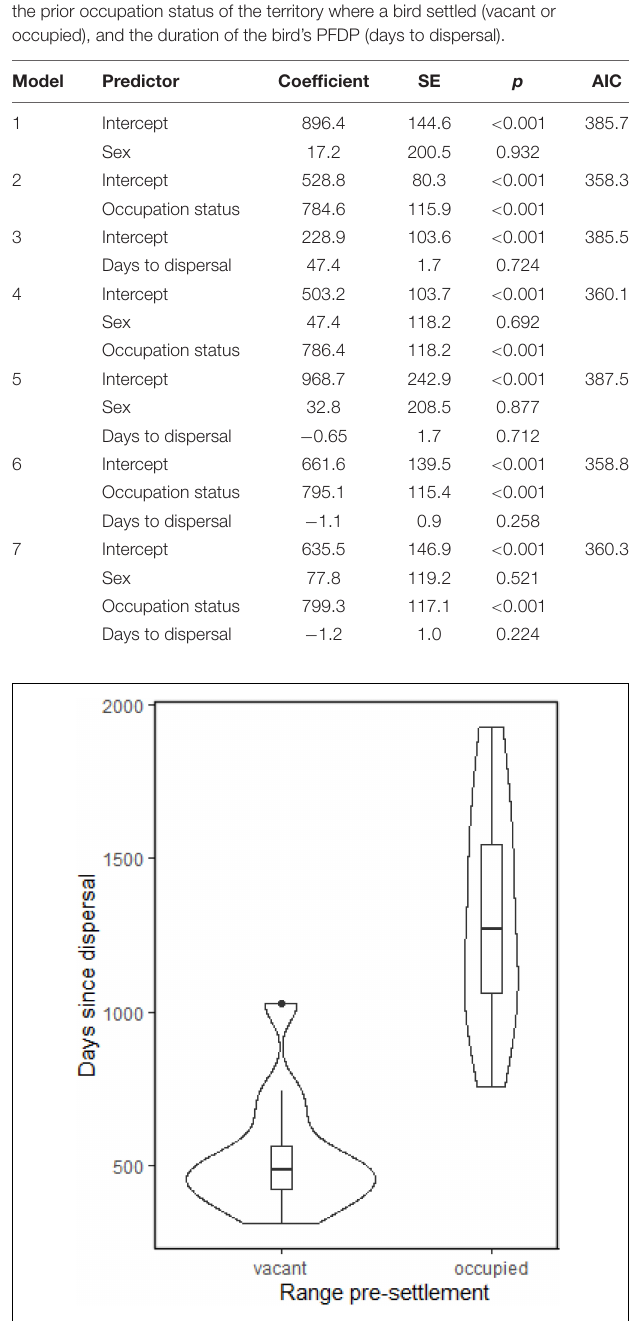
FIGURE 6 | Violin plots of days to settle (AFTS: days since dispersal initiation) with boxplot inserts according to the prior occupation status of the territory where a bird settled (vacant or